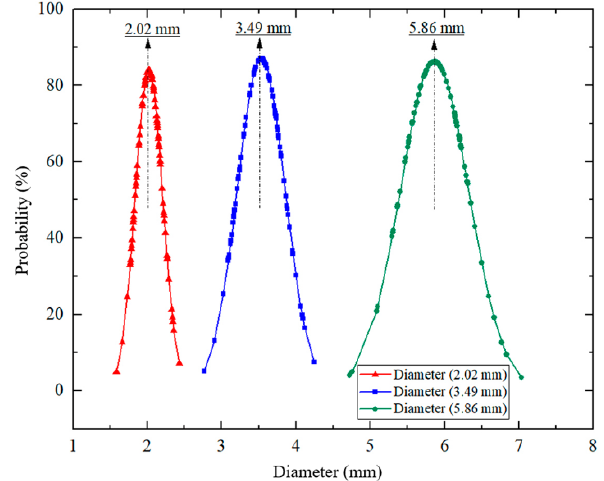
Figure 1. Normal distribution of lightweight expanded clay (LECA) particles.